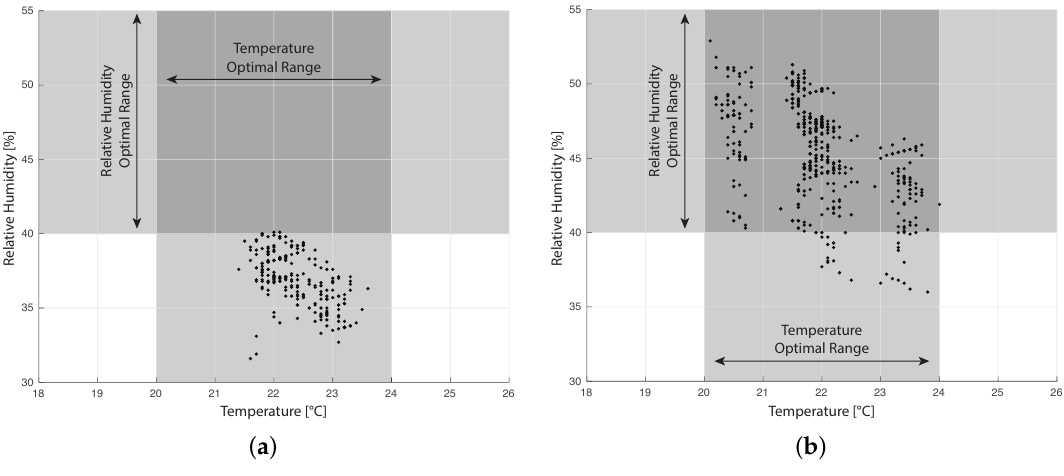
Figure 12. Relative humidity vs. temperature plots of cold air data. The grey zone represents the optimal suggested values of temperature and humidity to maximize the hardware life cycle. ( a ) First campaign; ( b ) second